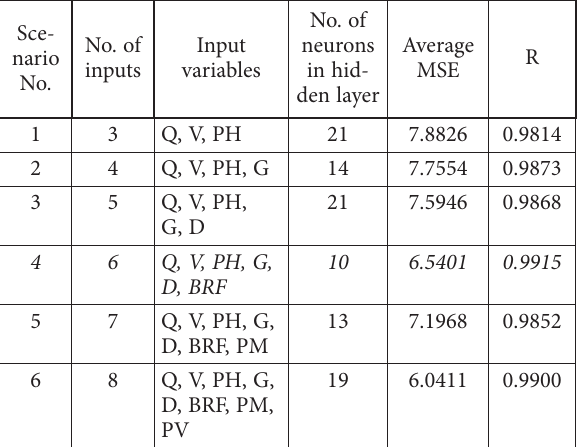
Table 5. Summary of defined scenarios and their best